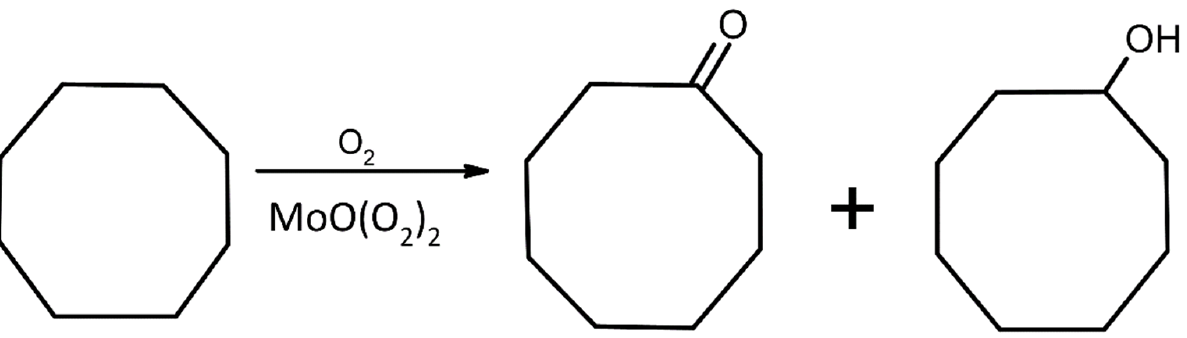
Figure 6. Scheme of cyclooctane oxidation with molecular oxygen and peroxidomolybdates as cat- alysts.